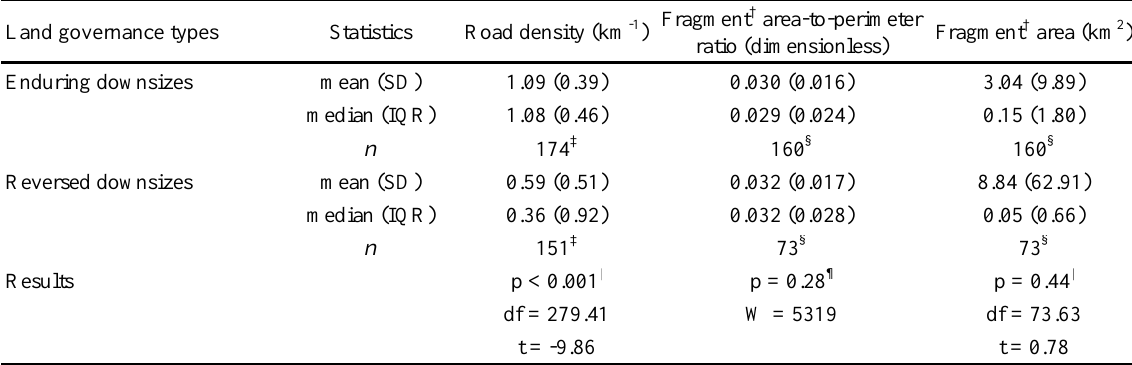
Table 1. Habitat fragmentation indicators in enduring and reversed downsizes for forested